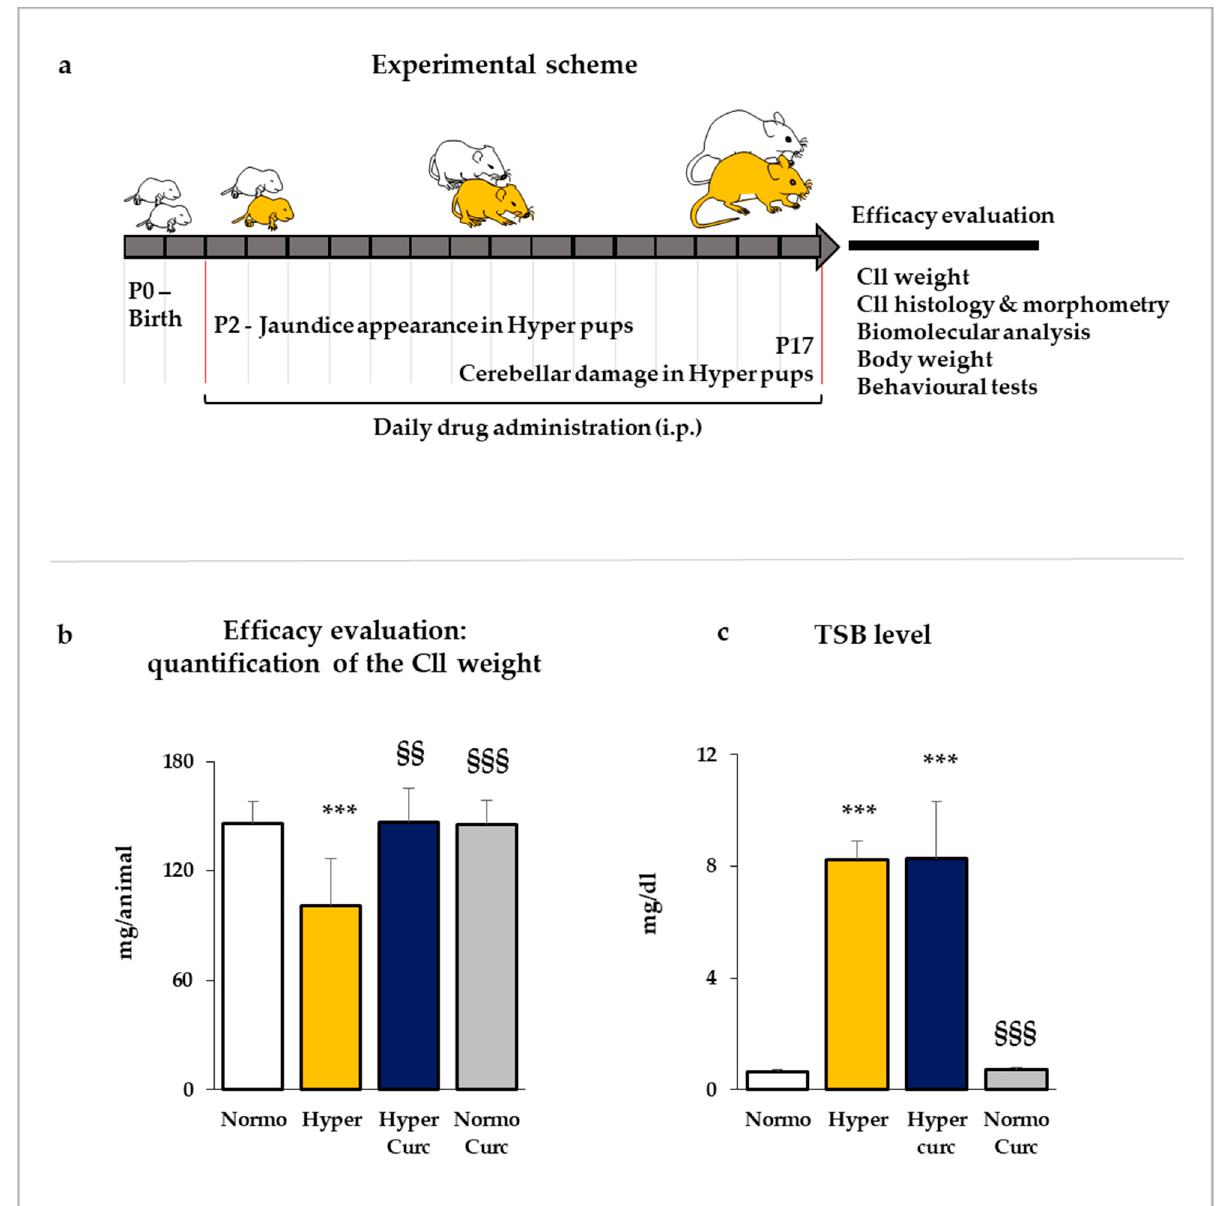
Figure 1. Experimental plan and efficacy of curcumin in rescuing cerebellar hypoplasia. ( a ) Two days after birth (P2: post-natal age in days), the litters composed both by normobilirubinemic (Normo—white) and hyperbilirubinemic (Hyper— yellow) pups were daily injected intraperitoneally (i.p.) with curcumin (Curc). At P17, the animals were sacrificed, and the cerebellum (Cll) was submitted for different analyses to deeply evaluate the drug efficacy and the mechanisms of action. ( b ) The Cll weight (expressed in mg/animal) in P17 pups was quantified and used as a first, immediate evaluation of the efficacy of the treatment. ( c ) Total serum bilirubin (TSB in mg/dL) was quantified in each group to monitor any potential alteration due to the treatment. Both ( b , c ) With white bars—untreated normobilirubinemic (Normo) Gunn pups; yellow bars—untreated hyperbilirubinemic rats (Hyper); blue bars—curcumin-treated hyperbilirubinemic pups (Hyper Curc); gray bars—curcumin-treated normobilirubinemic pups (Normo Curc). Data were expressed as mean ± S.D. In each experimental group, ≥ 10 animals were considered. Statistical significance was evaluated by the one-way analysis of vari- ance (ANOVA), followed by a Tukey–Kramer Multiple Comparisons Test when p -value < 0.05. Statistical significance: ***: p < 0.001 vs. Normo pups. §§, §§§: p < 0.01, p < 0.001 vs. Hyper rats.